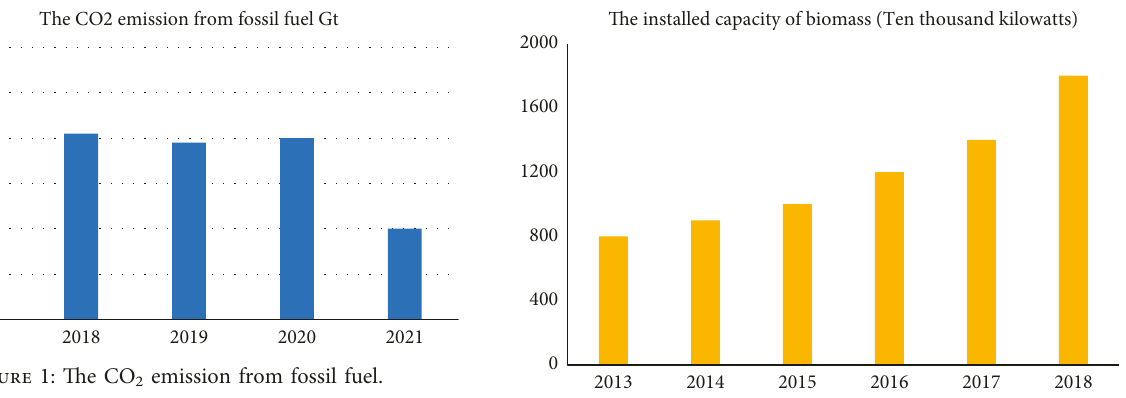
Figure 2: The installed capacity of biomass.